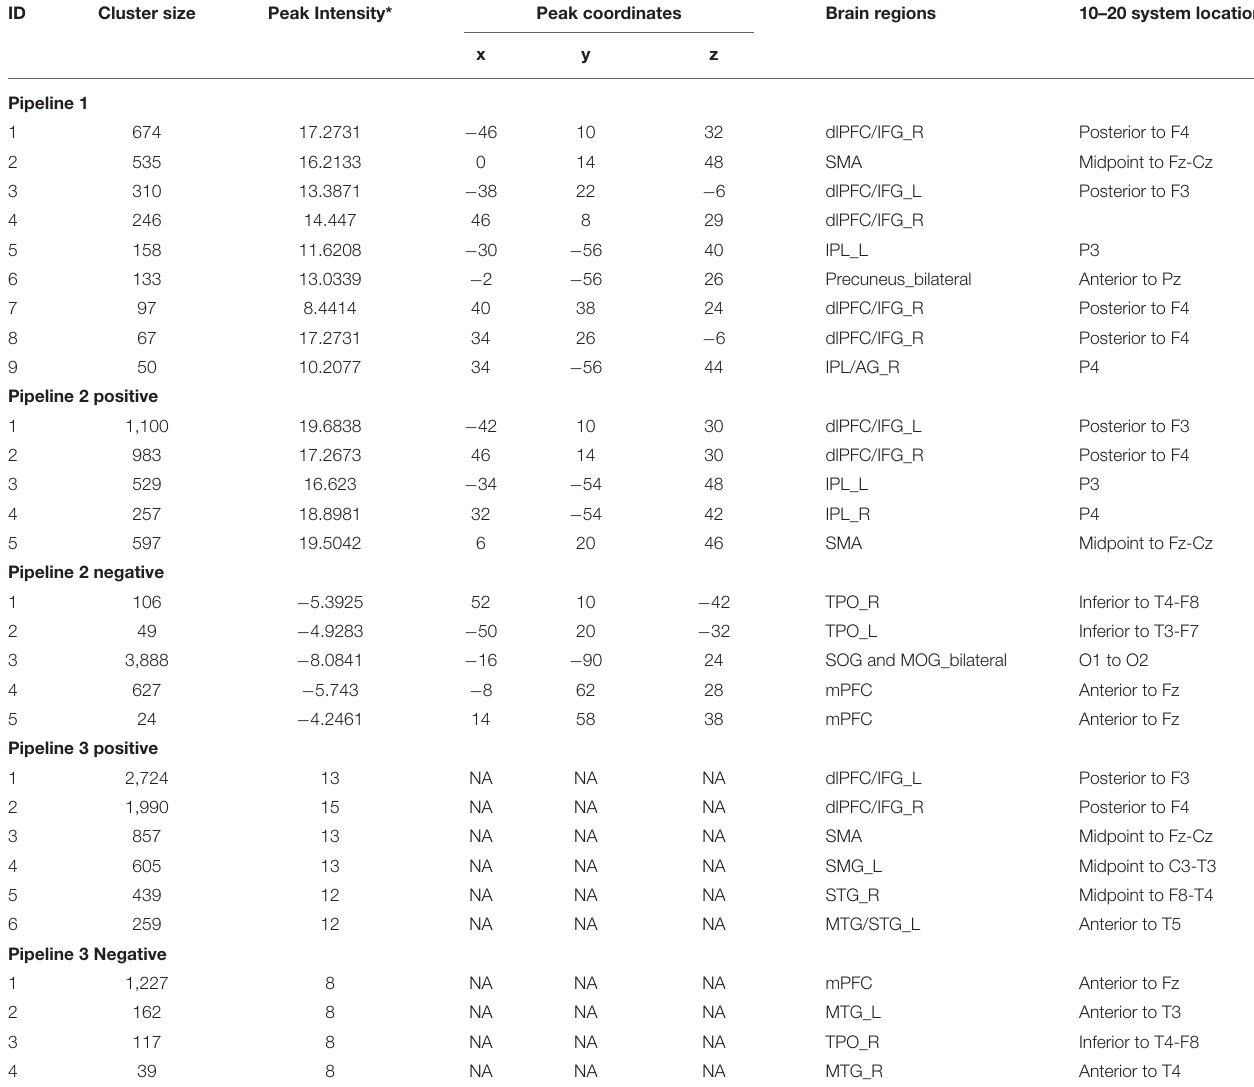
TABLE 2 | Potential locations for non-invasive brain stimulation (NIBS) techniques in SCZ from the three pipelines. ID Cluster